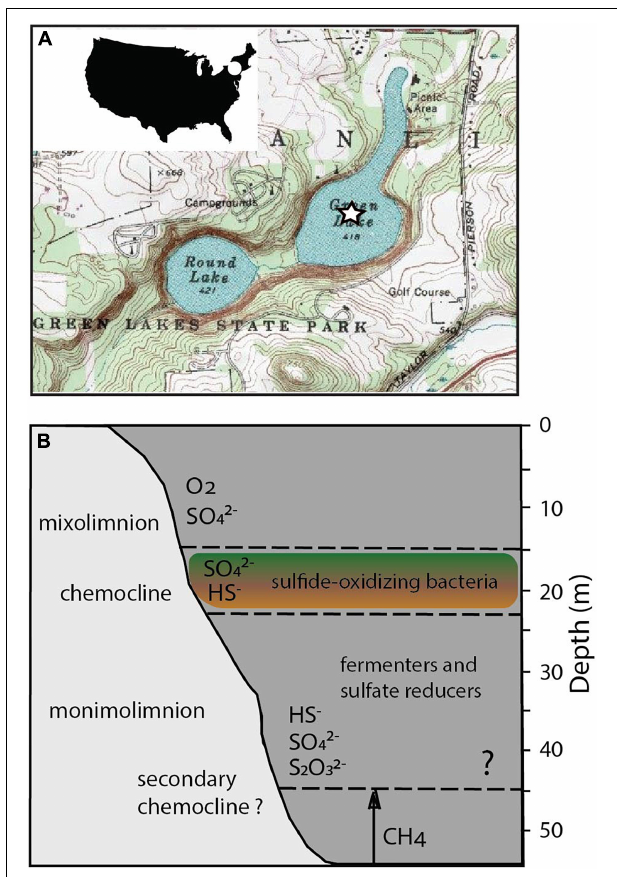
FIGURE 1 | Location and biogeochemical profiles of FGL. (A) United States Geological Survey map of FGL and the surrounding area. The star indicates the sampling site at the deepest part of the lake. (B) Stratification of major microbial metabolisms, O 2 , H 2 S, and methane in FGL. Question mark indicates the depth of the hypothesized secondary chemocline (Torgersen et al., 1981; Zerkle et al.,